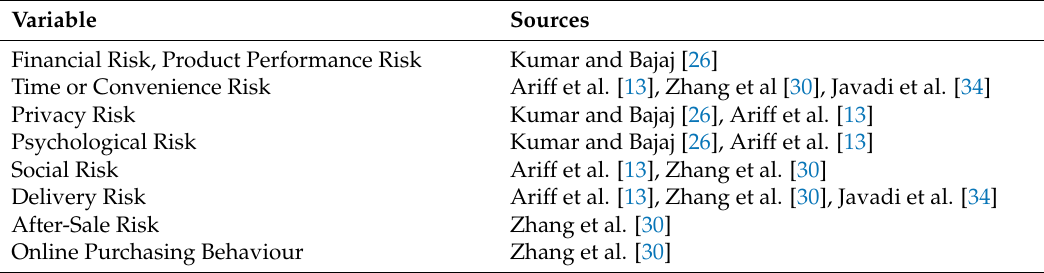
Table 2. List of variables and sources of